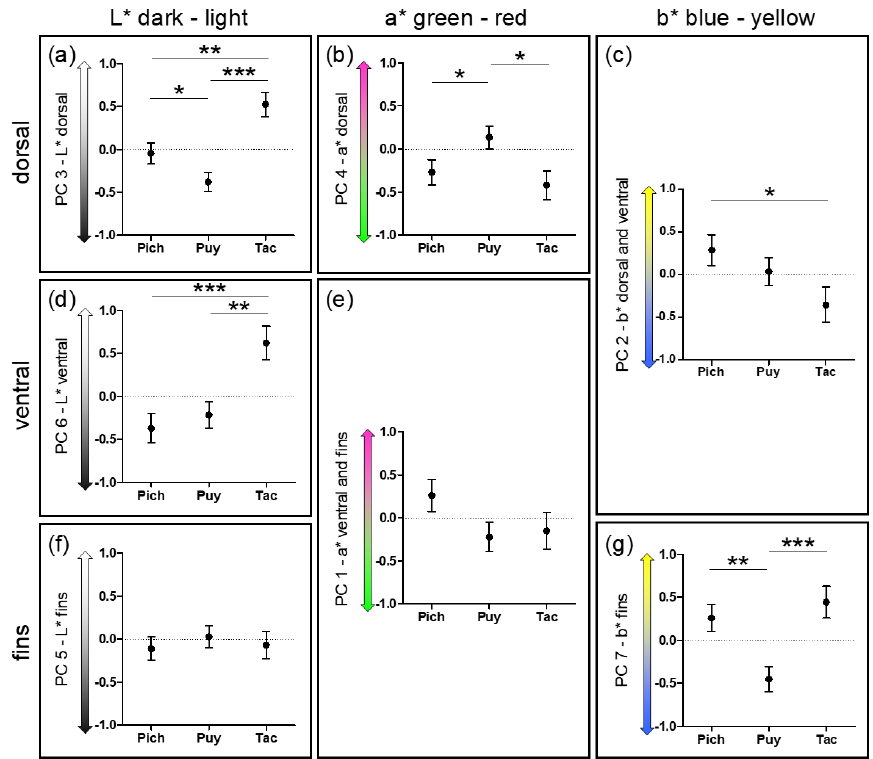
Figure A2. Illustration of the significant effect of ‘drainage’ detected in the main MANCOVA model using PC scores as dependent variables (see Table 2). Shown are estimated marginal means ± SE obtained from post hoc ANCOVAs. The results are grouped by body region (dorsal area ( a – c ), ventral area ( d , e ), and fins ( f , g )) and the color ( L *, a * and b *) captured by the respective PC. The asterisks indicate significant results of the post hoc pairwise comparisons (Fisher’s LSD; * p < 0.05, ** p < 0.01, *** p < 0.001).